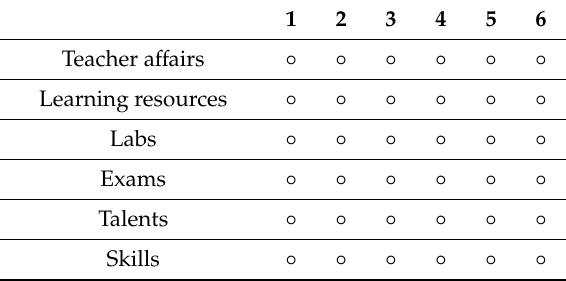
Table A1. Rank the services you use in the Noor system.